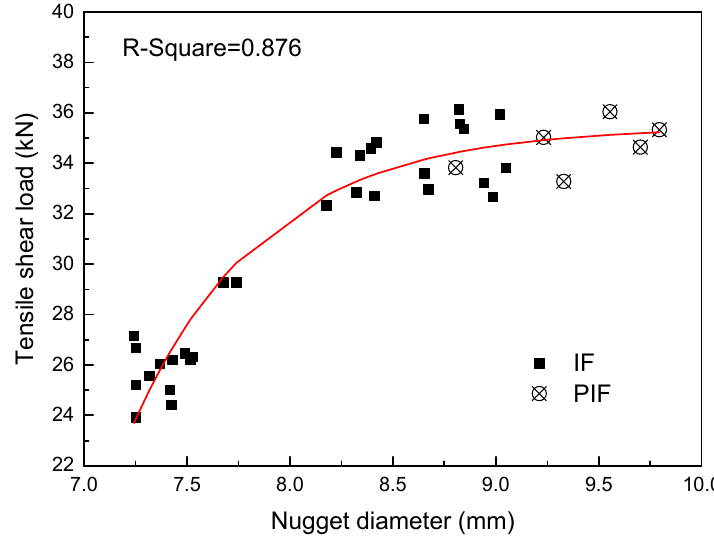
Figure 10. Effect of nugget diameter on the tensile-shear load and failure mode.